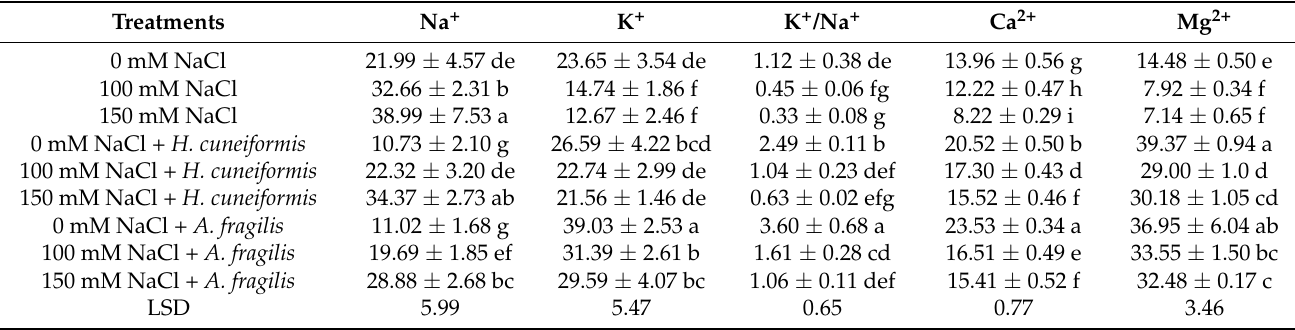
Table 3. The effect of salinity stress on leaf nutrient contents (mg g − 1 DW) of wheat ( Triticum aestivum L.) primed with H. cuneiformis and A. fragilis